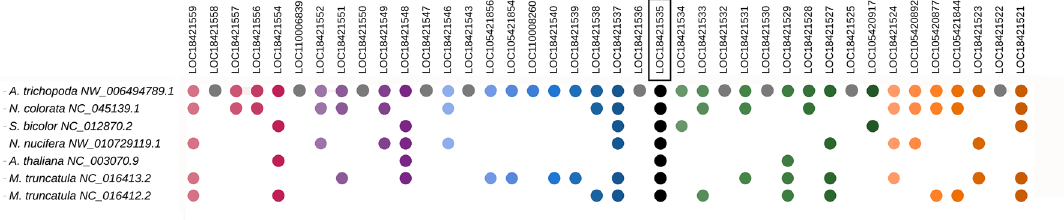
Figure 6. Microsynteny analysis of angiosperm H-DHNs genes. The genomic neighbourhood of the H-DHN gene of A. trichopoda (LOC18421535) is compared to that of other angiosperms. H-DHN genes are indicated as black dots, and a colour code indicates homologous genes present in the other species. Grey dots indicate genes only present in A. trichopoda . Some intervening genes in species other than A. trichopoda are not shown for